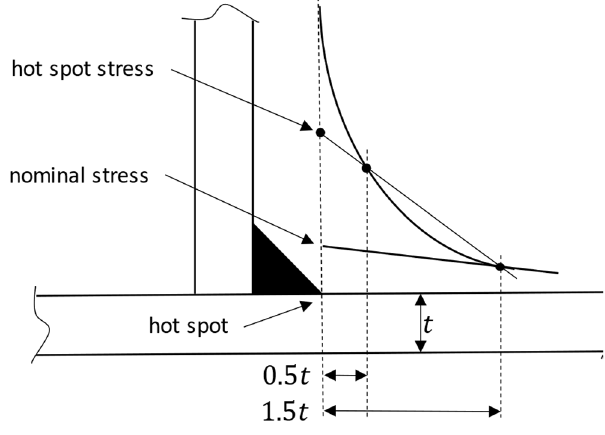
Figure 3. Different stress levels applied in SN fatigue analyses, adopted from [29].